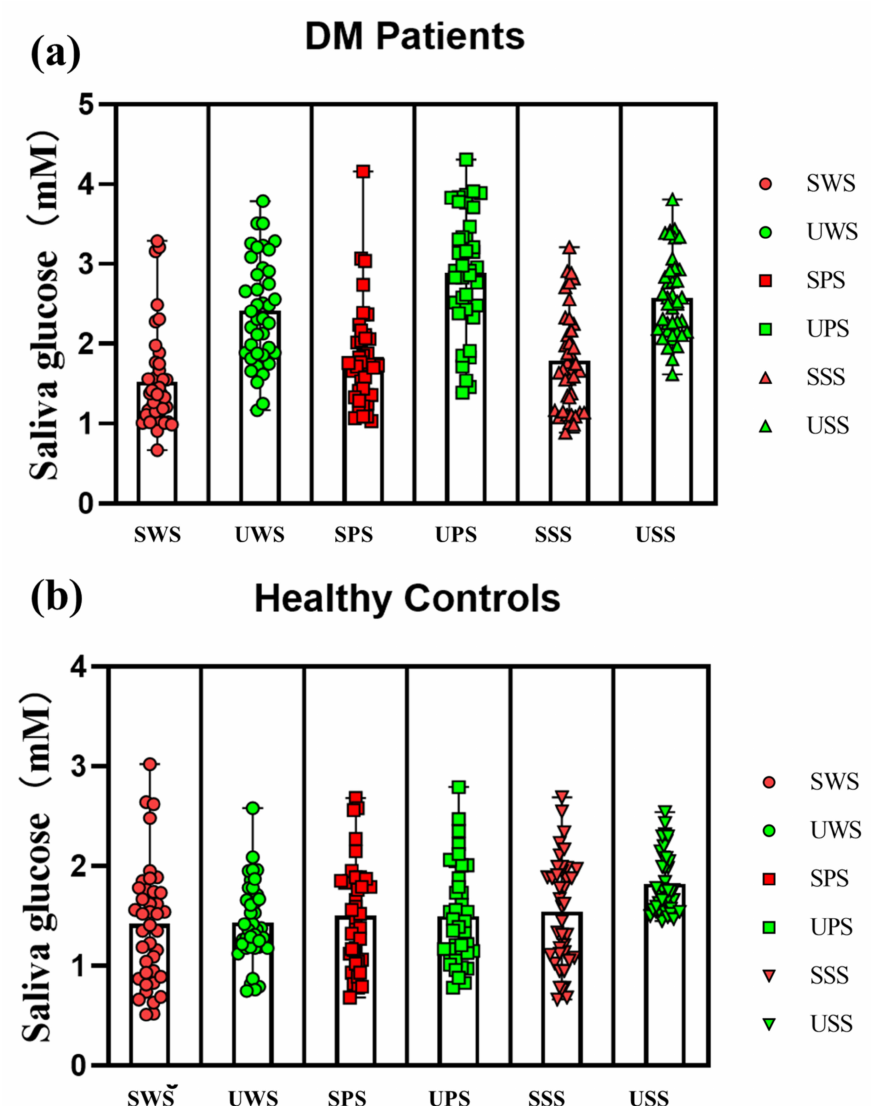
Figure 2. Salivary glucose levels in all participants, ( a ) DM patient group, ( b ) Healthy control